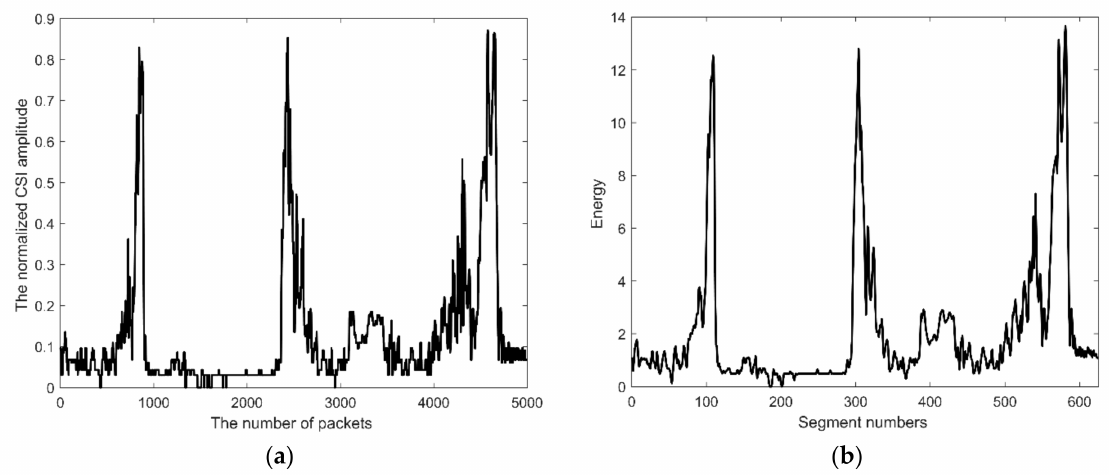
Figure 4. ( a ) The normalized signal. ( b ) The short-time energy of the normalized